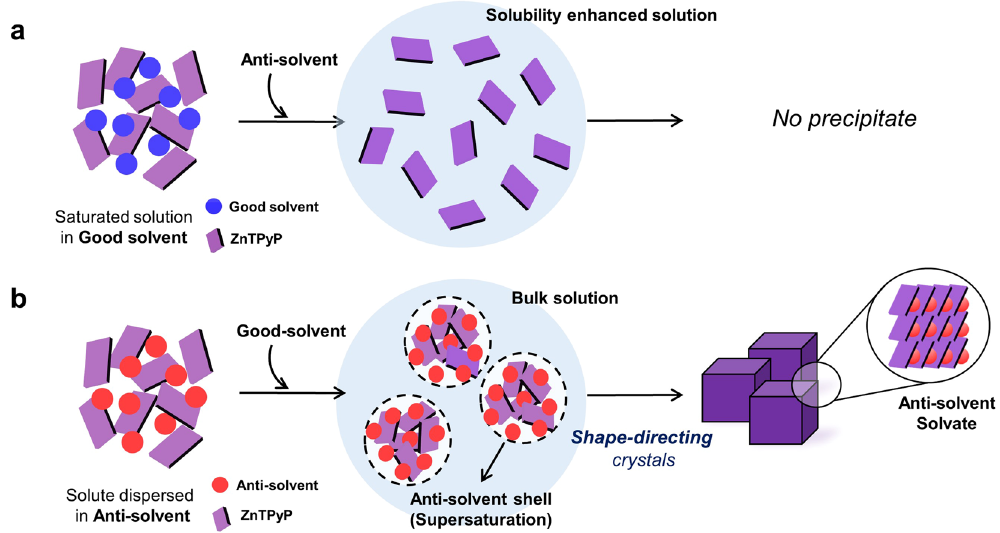
Figure 1. Scheme of c -ASC and r -ASC methods. ( a ) Conventional anti-solvent crystallization ( c -ASC) method and ( b ) reverse anti-solvent crystallization ( r -ASC) method, which reverse the solvent-addition order compared with the c -ASC